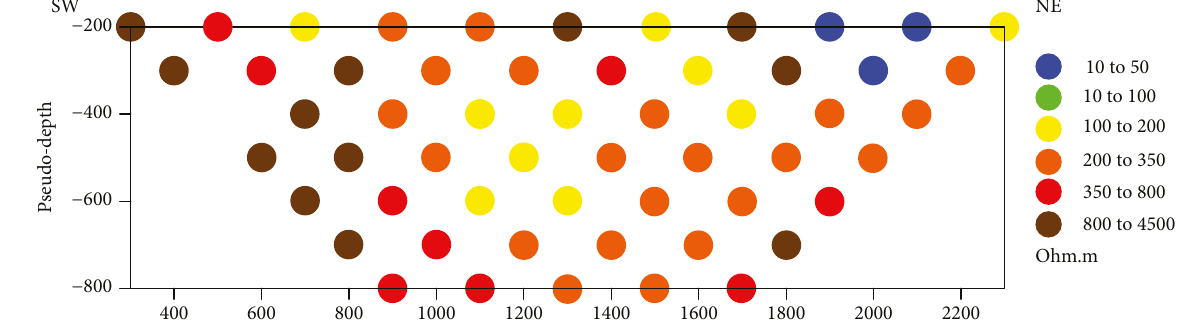
Figure 4: Distribution of the calculated apparent resistivity